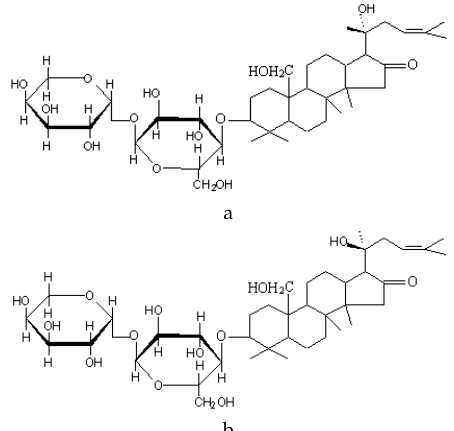
Figure 1. ( a ) Bacoside A (Levorotatory) [38]; ( b ) Bacoside B (Dextrorotatory) [38].